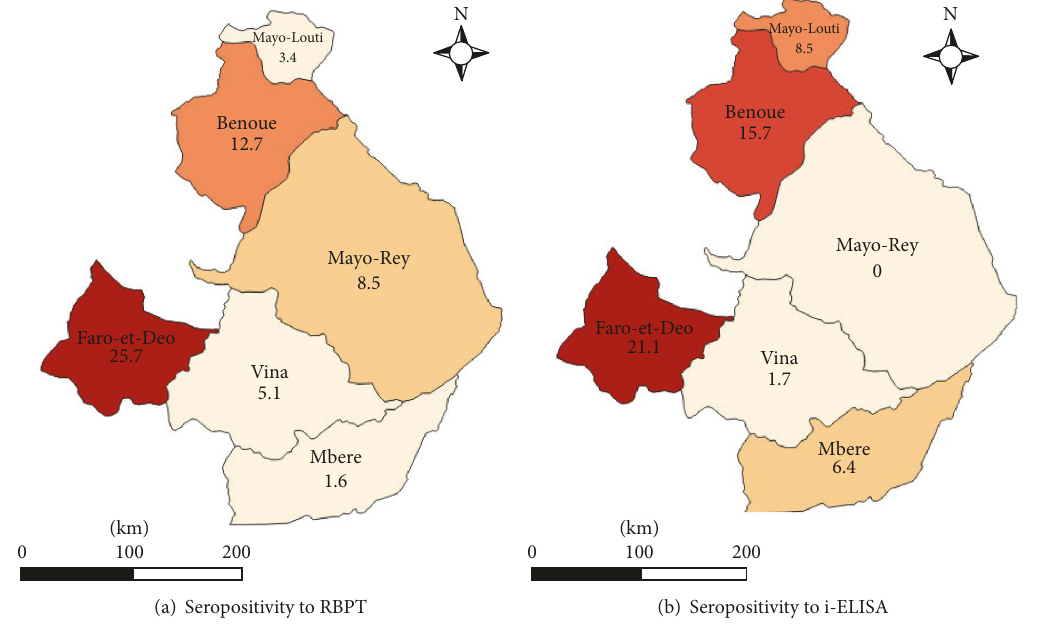
Figure 2: Map showing distribution of apparent seroprevalence rates at individual animal level according to locality and diagnostic test.